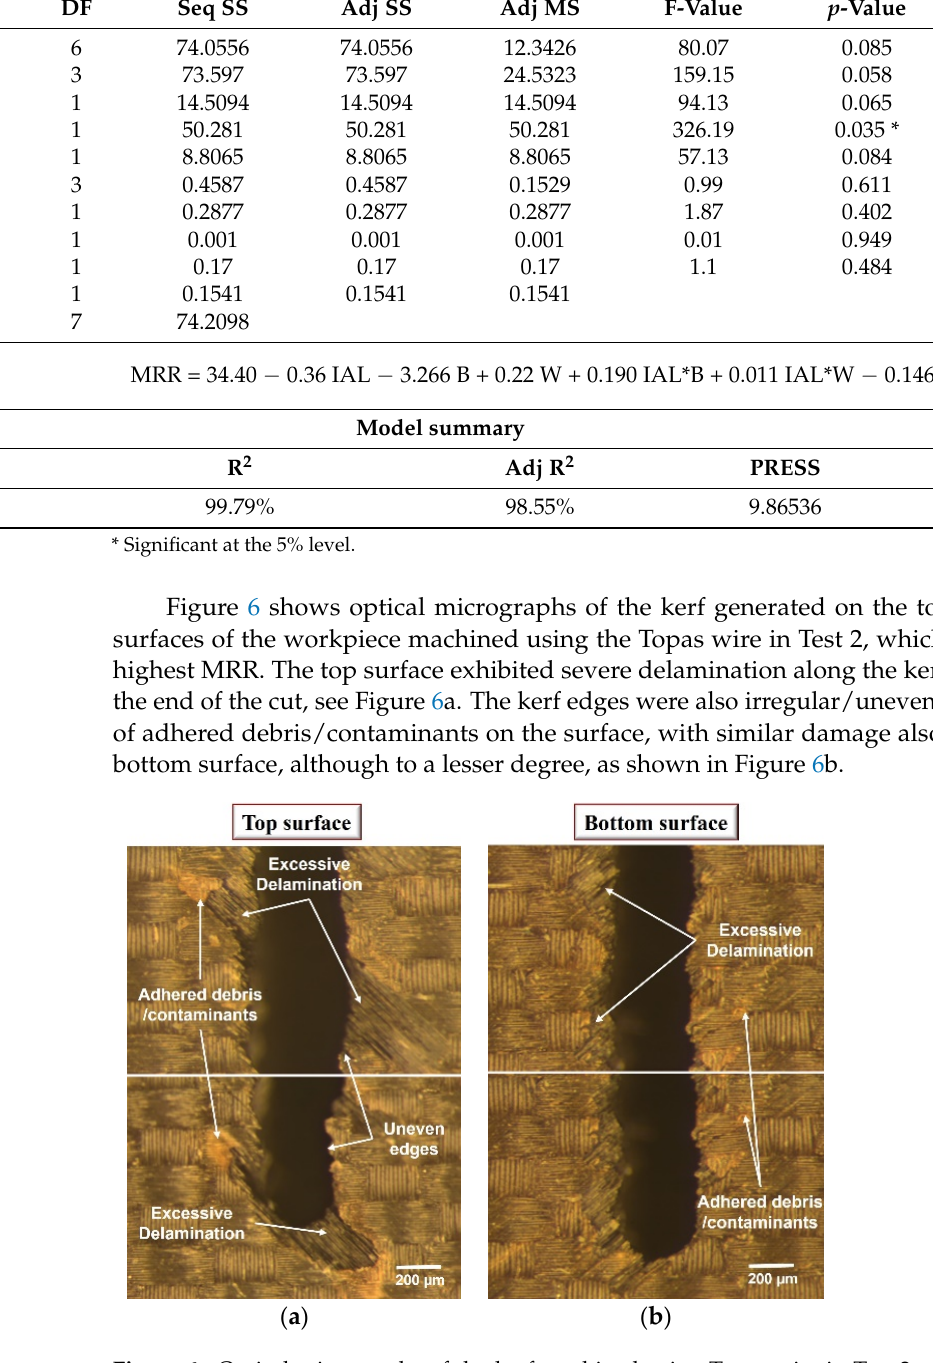
Figure 6. Optical micrographs of the kerf machined using Topas wire in Test 2 at the ( a ) top and ( b ) bottom surface.